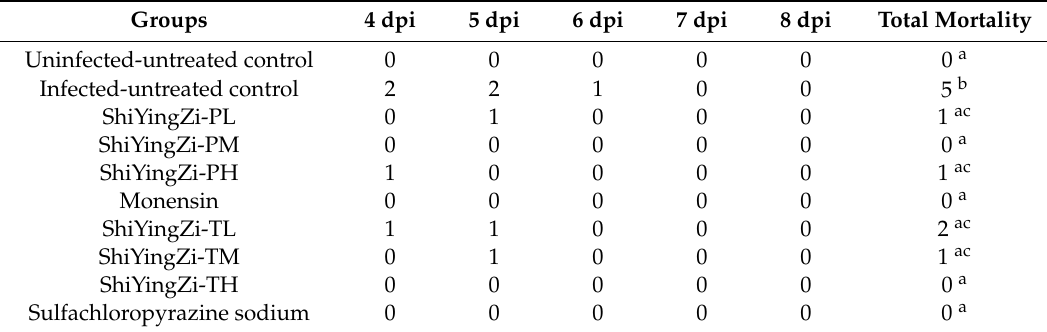
Table 1. Mortality in di ff erent groups from 4 to 8 days post infection (dpi). Groups 4